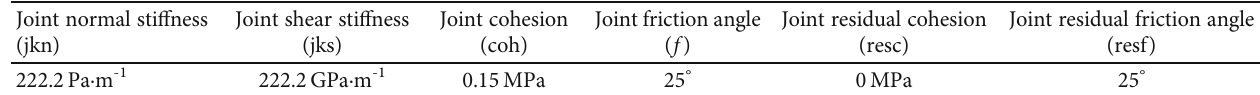
Table 2: Joint mechanical parameters in numerical simulation.